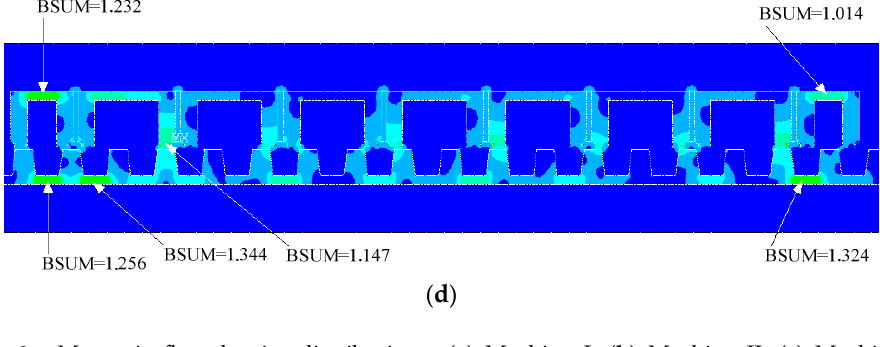
Figure 8. Magnetic flux density distribution. ( a ) Machine I; ( b ) Machine II; ( c ) Machine III; ( d ) Machine IV.